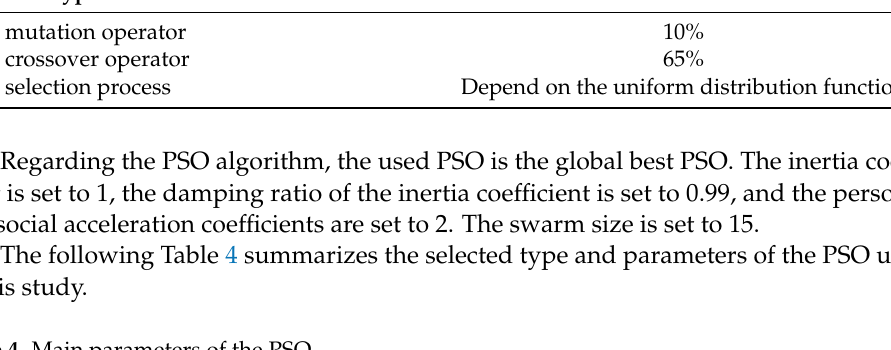
Table 4. Main parameters of the